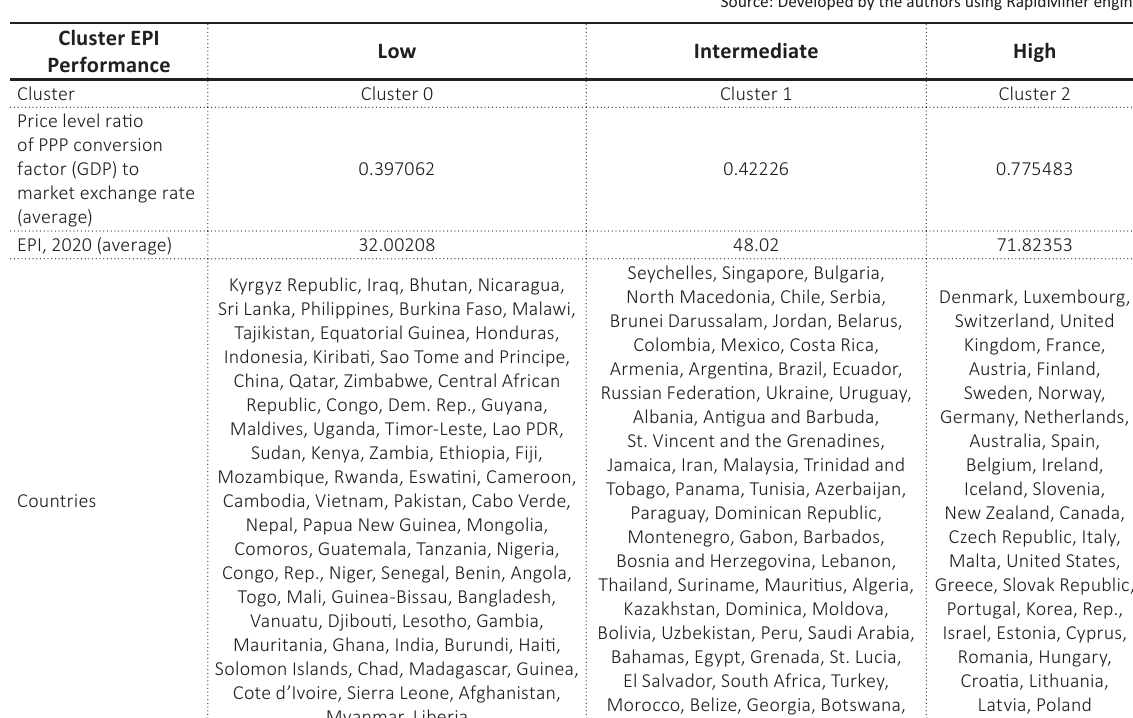
Source: Developed by the authors using RapidMiner engine.